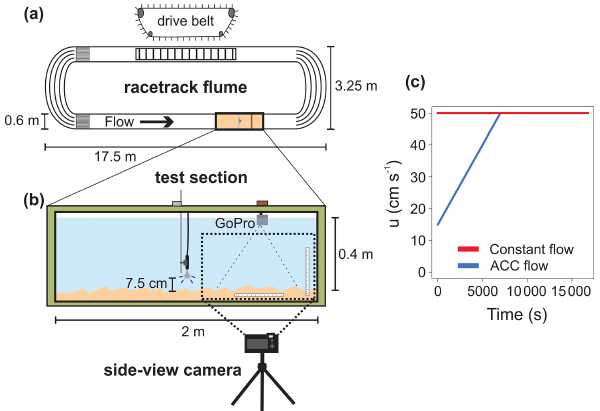
Figure 1. (a) The top view of the NIOZ racetrack flume. (b) A side view of the 2m long test section showing the Nortek Vectrino ® acoustic Doppler velocimeter (ADV), GoPro and side-view cameras used in each experimental run. Both cameras were positioned within the second half of the viewing window of the test section. (c) The flume flow settings implemented in the two separate experiments. Note that although ripples are shown for illustrative purposes, the indicated water depth and ADV height are based on the initial (flat bed)